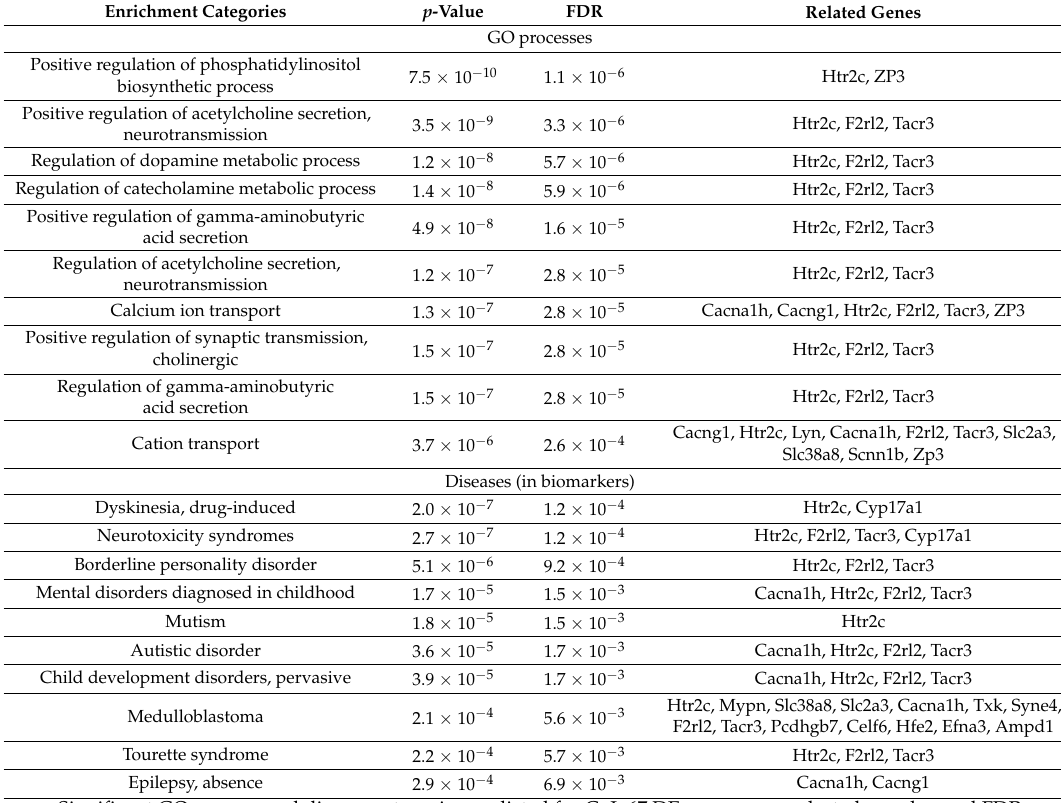
Table 7. MetaCore enrichment analysis of DE genes in CvI.